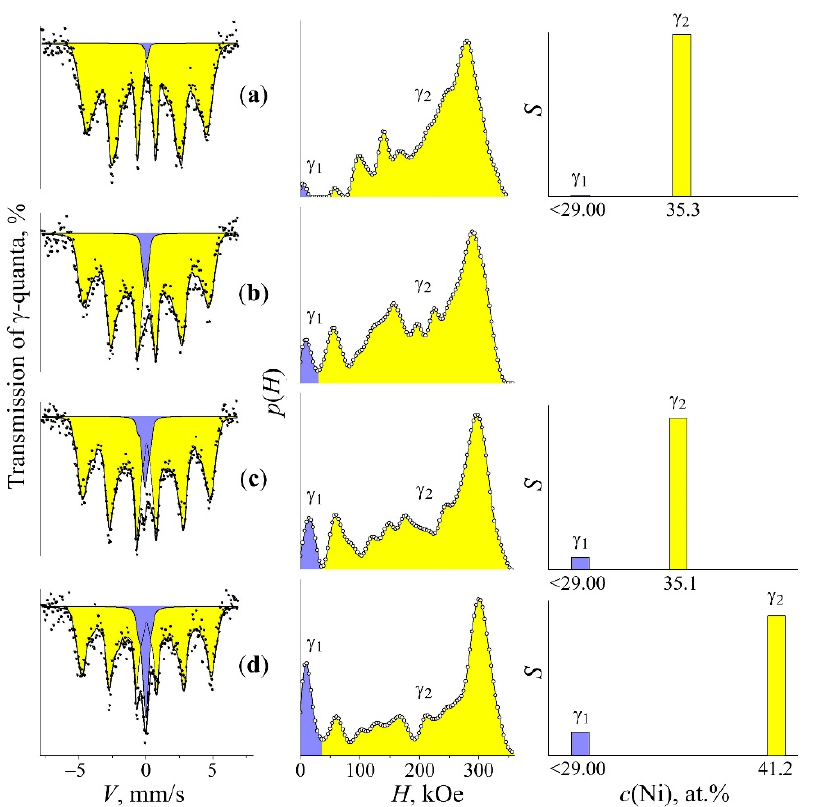
Figure 5. The Mössbauer spectra, the spectral components γ 1 and γ 2 reconstituted using p ( H ) and histograms of intensities S of Mössbauer spectra components and the concentration composition c (Ni) of the FeNi 31.1 alloy after electron irradiation, with electron energy of 5 MeV. Treatment: ( a ) tempering at 1050 °C for austenite, with subsequent quenching in water; ( b – d ) treatment described in ( a ) with further electron irradiation at 120 °C, with fluence of 10 18 , 2 × 10 18 , and 5 × 10 18 cm − 2 , respectively.